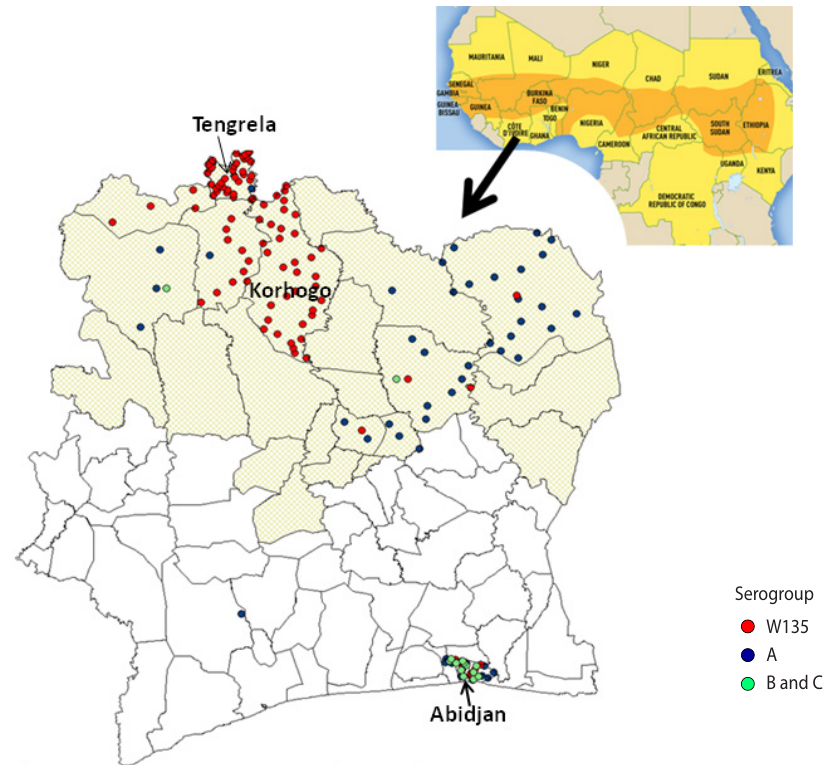
Figure 2. Spatial distribution of meningococcus strains isolated at the National Reference Center for meningitis from 2007 to 2012 by sero- group, Cote